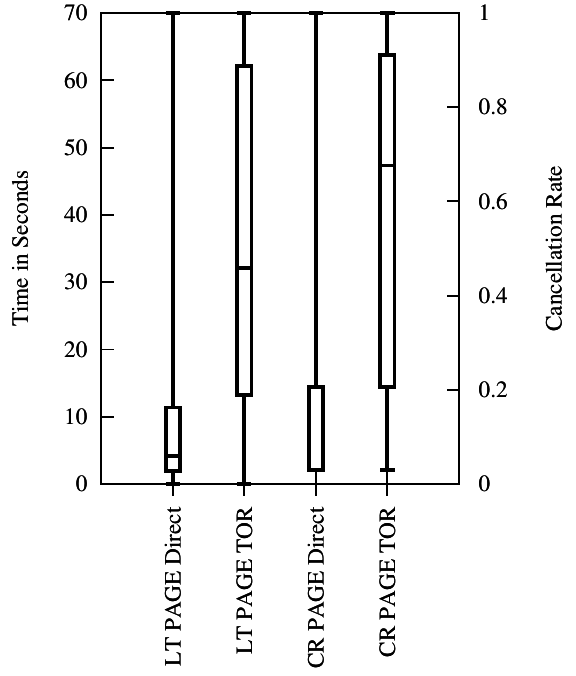
Figure 10. Page Latency and Cancelation Rate (Lab Experiment with